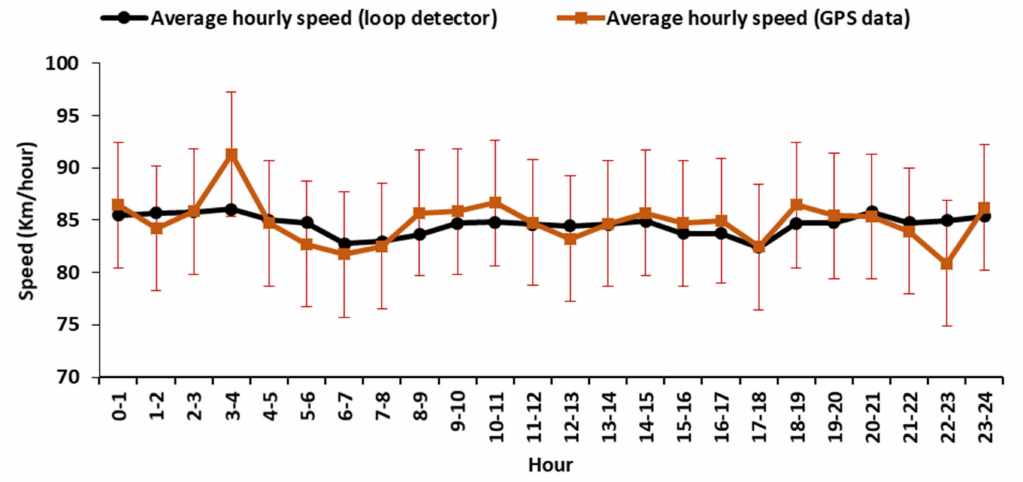
Figure 11. Comparison of hourly mean speed from station and GPS